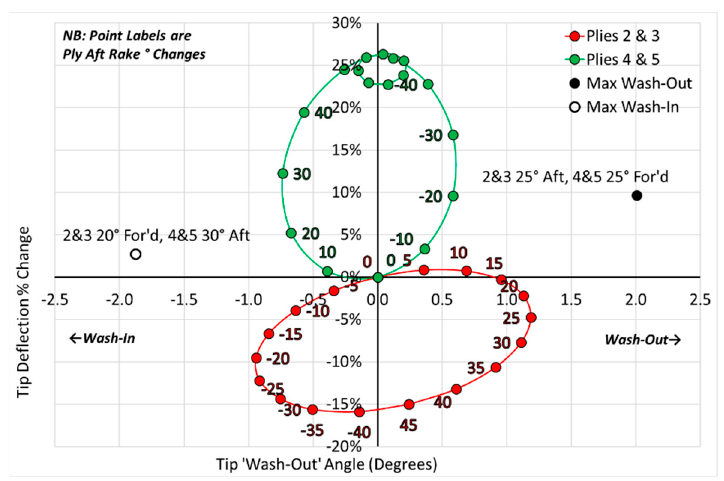
Figure 25. Simple point load variation of tip deflection and twist with ply angles.